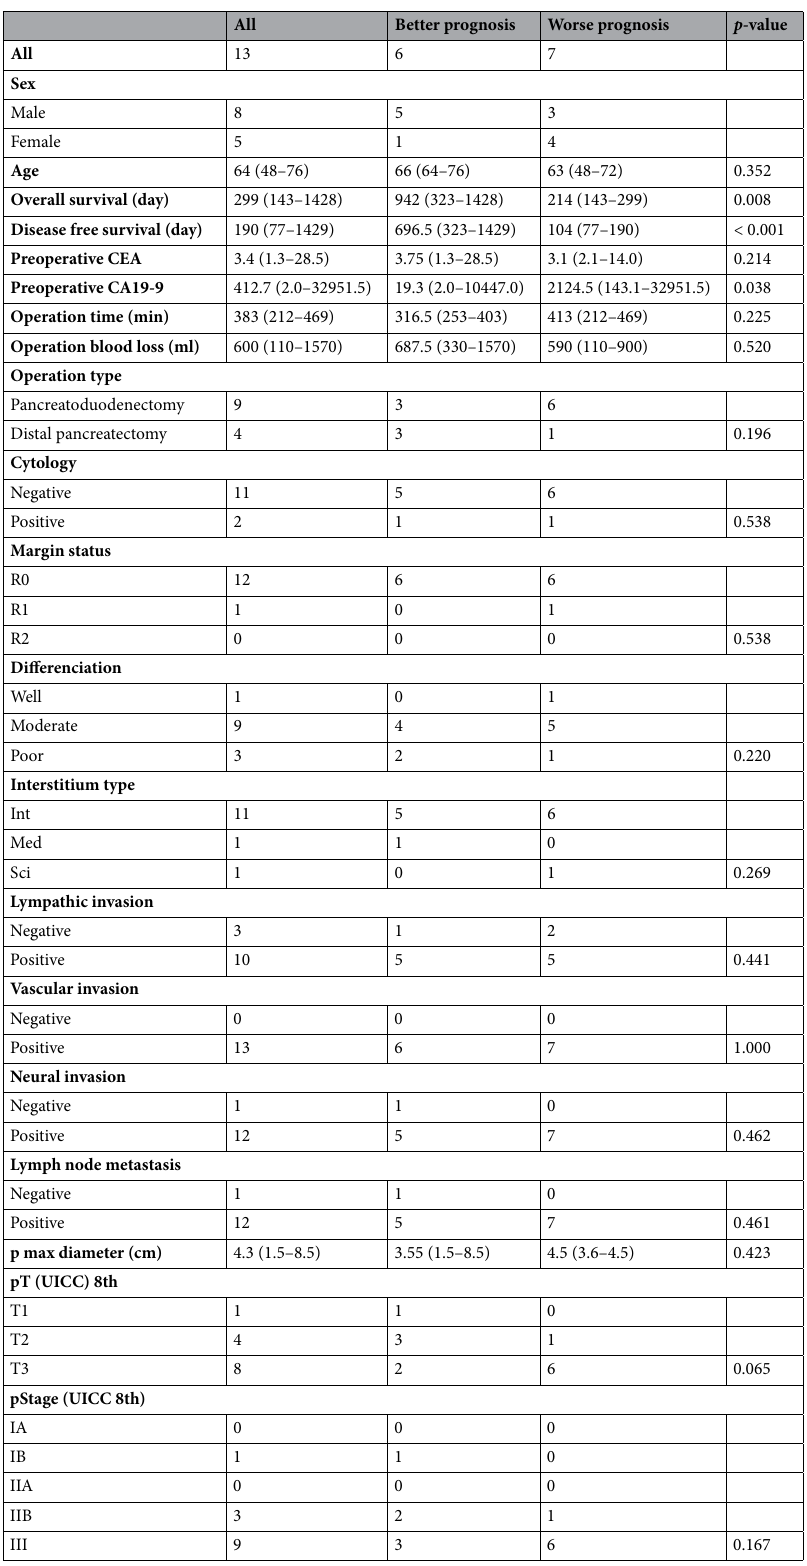
Table 1. Clinical background for pancreatic